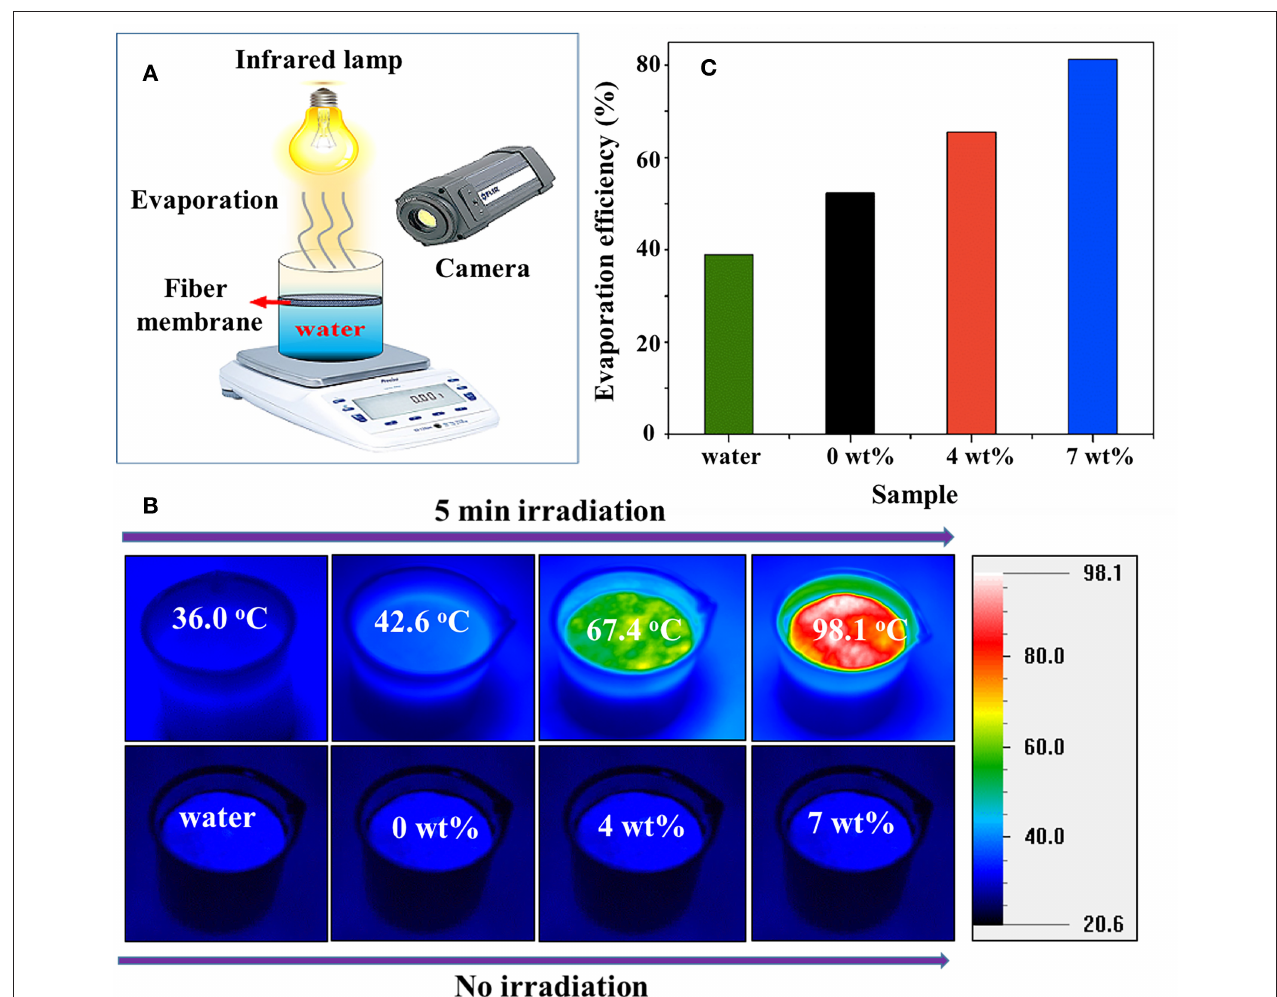
FIGURE 4 | (A) Schematic of water evaporation measurement with WO 2.72 /PLA fiber membrane floating on air-water interface, (B) temperature of WO 2.72 /PLA fiber membrane containing 0, 4, and 7 wt% WO 2.72 nanoparticles floating on water, and (C) evaporation efficiency for WO 2.72 /PLA fiber membrane containing 0, 4, and 7 wt% WO 2.72 nanoparticles. Reproduced with permission ( Chala et al., 2018a). Copyright 2018,